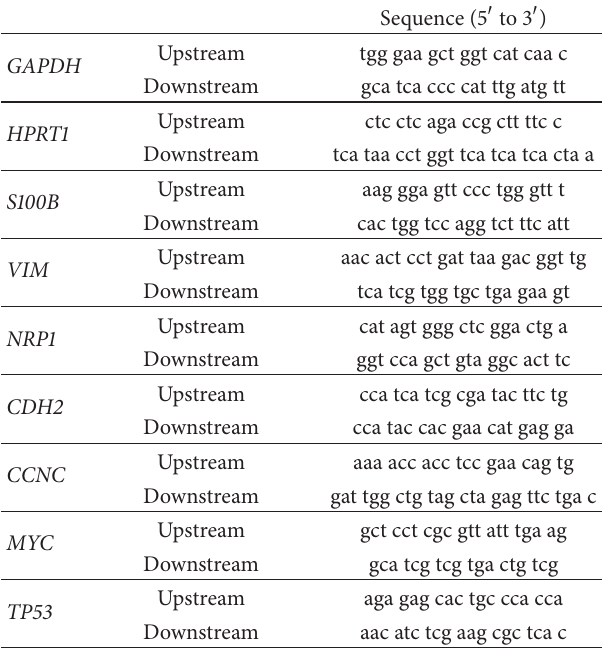
Table 1: Primers used in qRT-PCR.